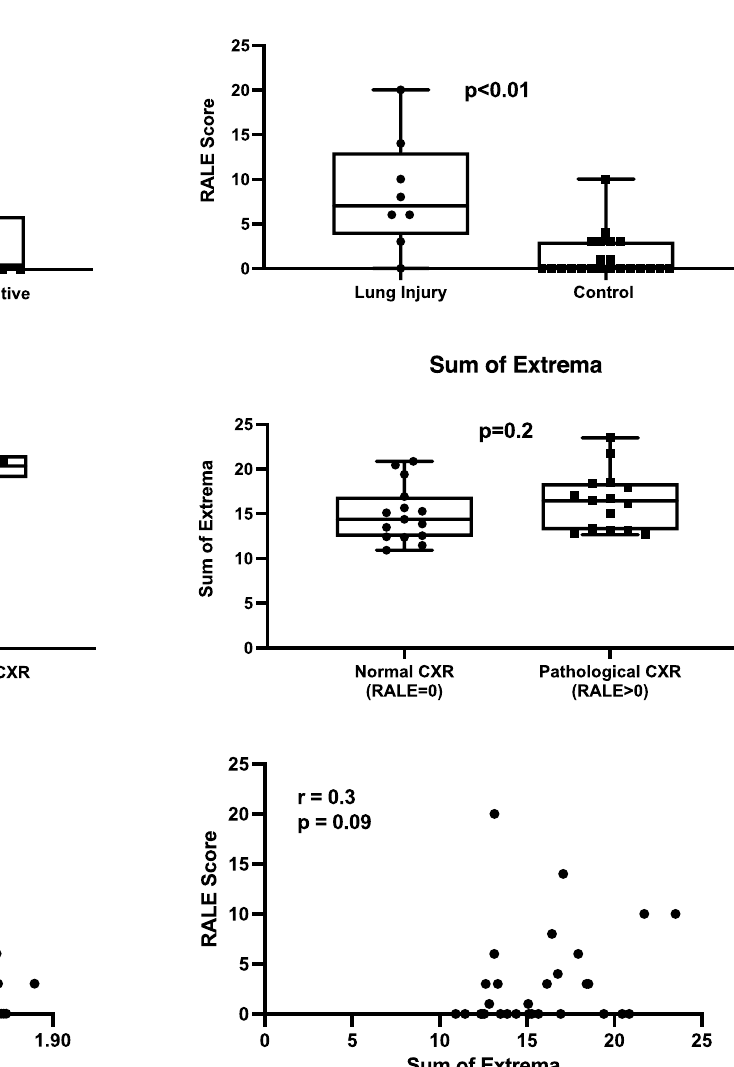
Figure 5. The correlation between thermal imaging and chest X-ray. ( A ) Box plots of RALE score according to COVID-19 and lung injury status. P value by Mann–Whitney test. ( B ) Box plots of the fractal dimension (FD) (left) and sum of extrema (SX) (right) thermal scores according to categorized RALE score. P value by Mann–Whitney test. ( C ) RALE scores were not correlated with thermal imaging scores. P value by Spearman’s correlation test. CXR chest X-ray, RALE radiographic assessment of lung edema.